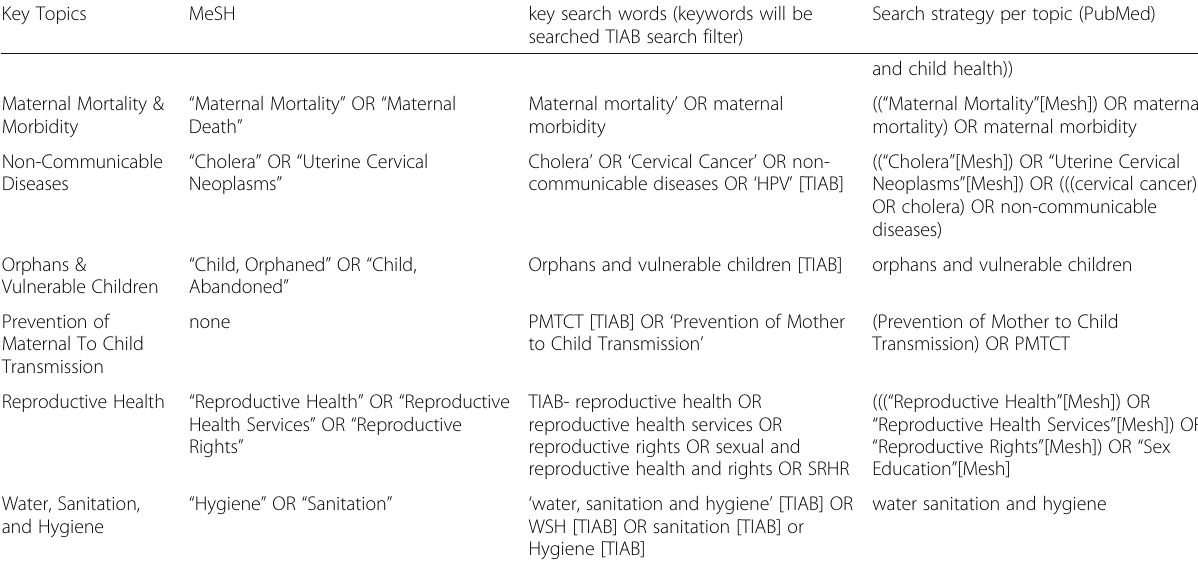
Table 7 Search Terms & Key Words per Focus Area (Continued) Key Topics MeSH key search words (keywords will be